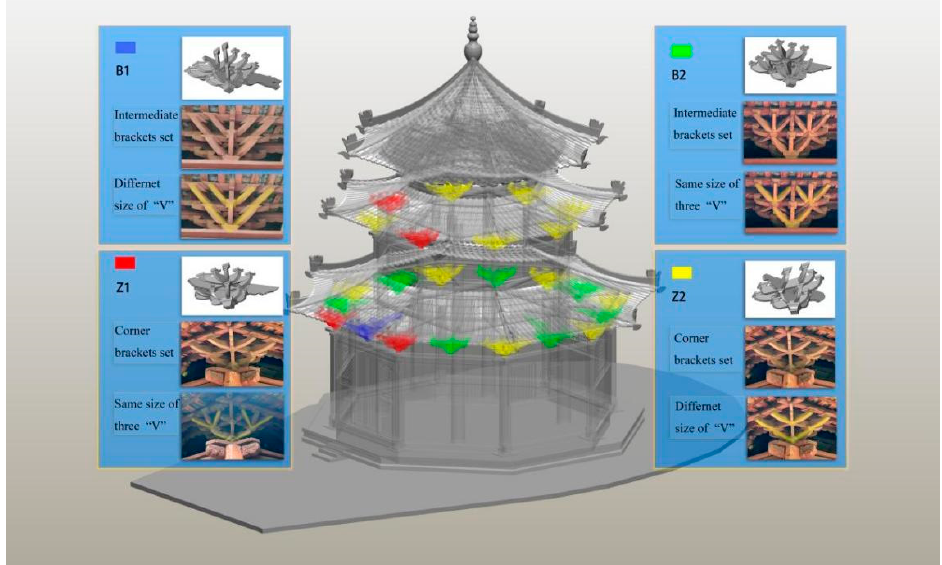
Figure 22. The shape of the bucket set.